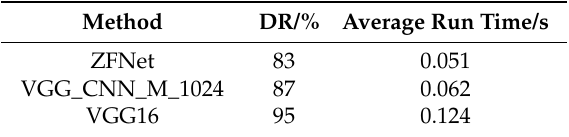
Table 3. Detection results using different pretraining networks.